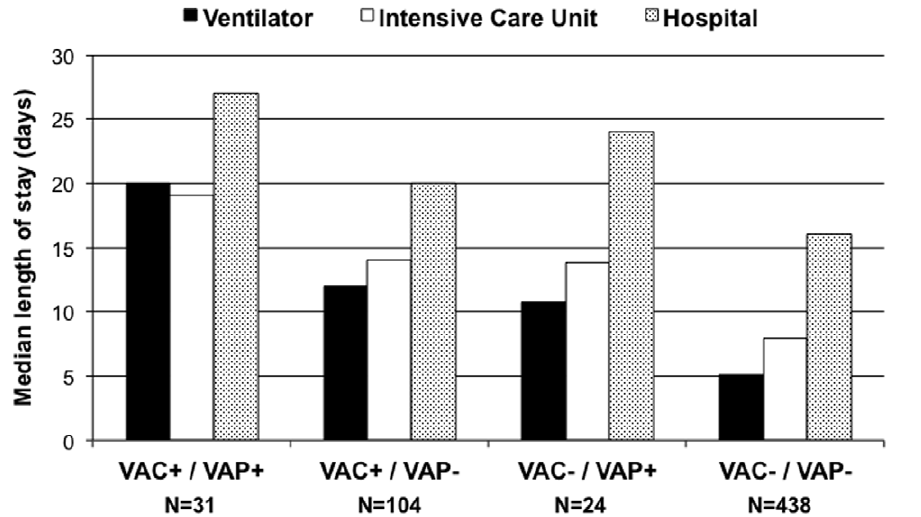
Figure 1. Median ventilator, intensive care unit, and hospital lengths of stay according to overlap pattern between patients with ventilator-associated complications (VAC) versus ventilator-associated pneumonia